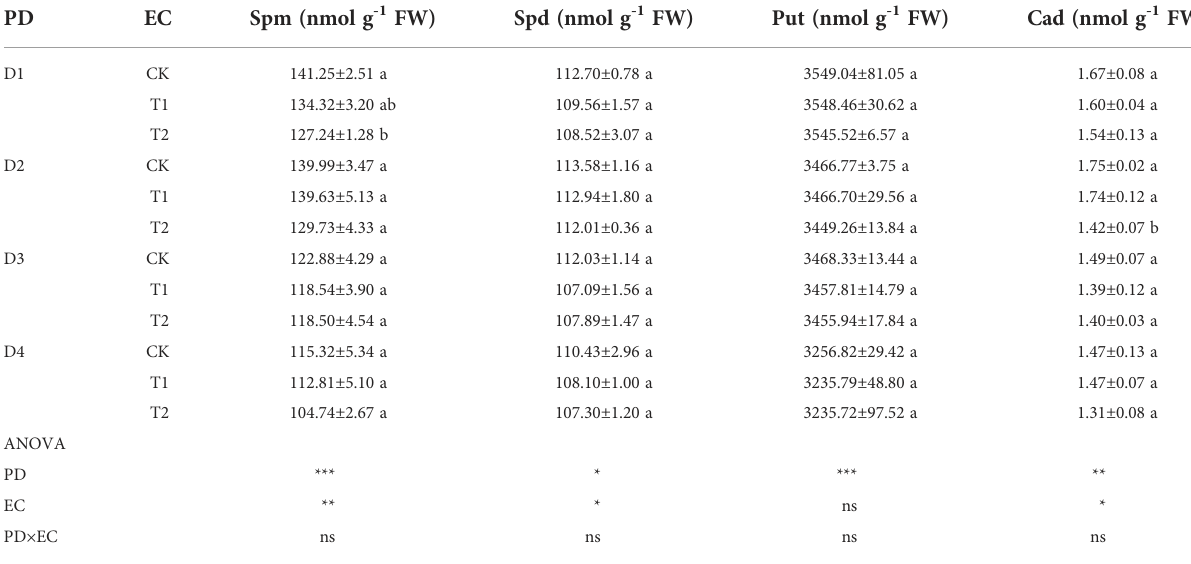
TABLE 5 Effects of EC and PD on spermidine (Spm), spermidine (Spd), putrescine (Put), and cadaverine (Cad) in grains of summer maize in